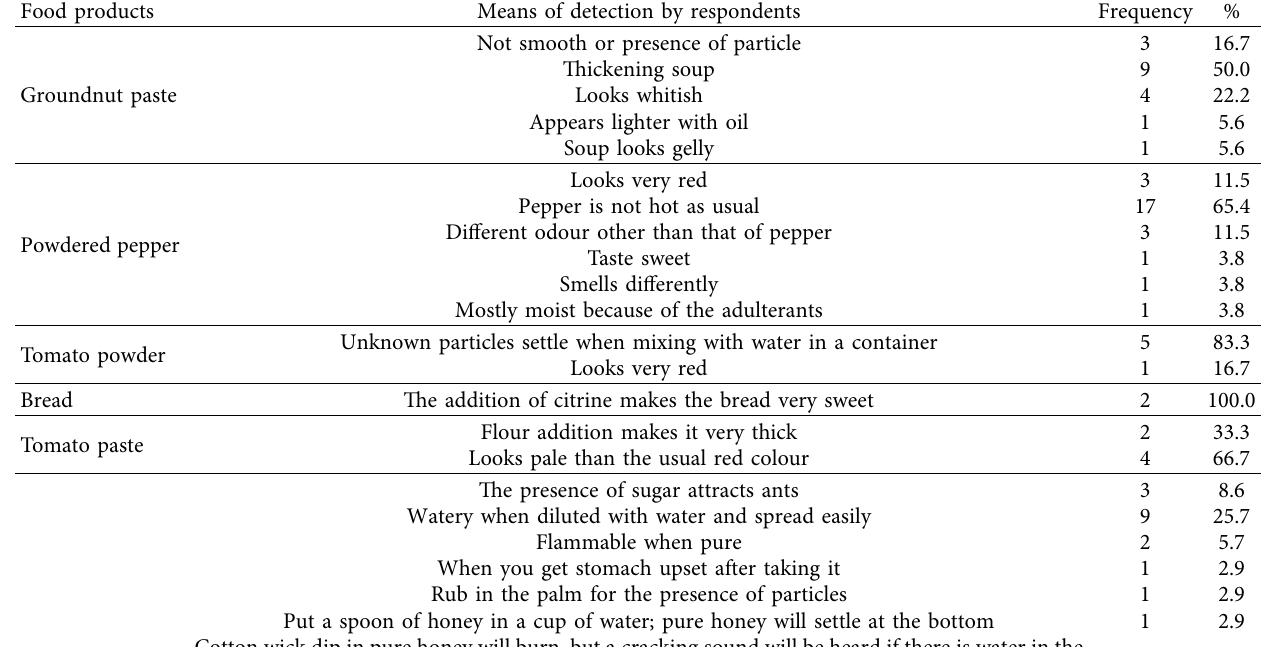
Table 6: Traditional means of detecting food adulteration by the respondents. Food